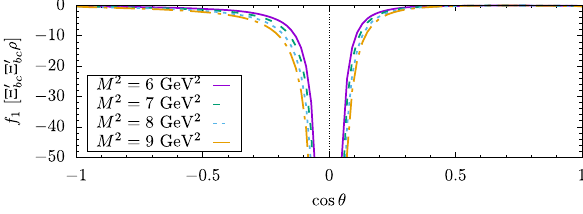
Ξ (cid:7) ρ on √ bc bc s 0 = 7 . 5